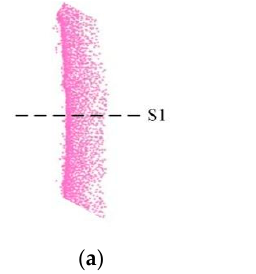
Figure 3. Branches separation based on the spatial connectivity of neighboring points set. { Set i } indicates the neighboring point set. Li represents the separated branches. Si along with the dotted line means the spatial connectivity analysis to the neighboring point set. Pi is the location where connectivity changes. Arrow means the growing direction.